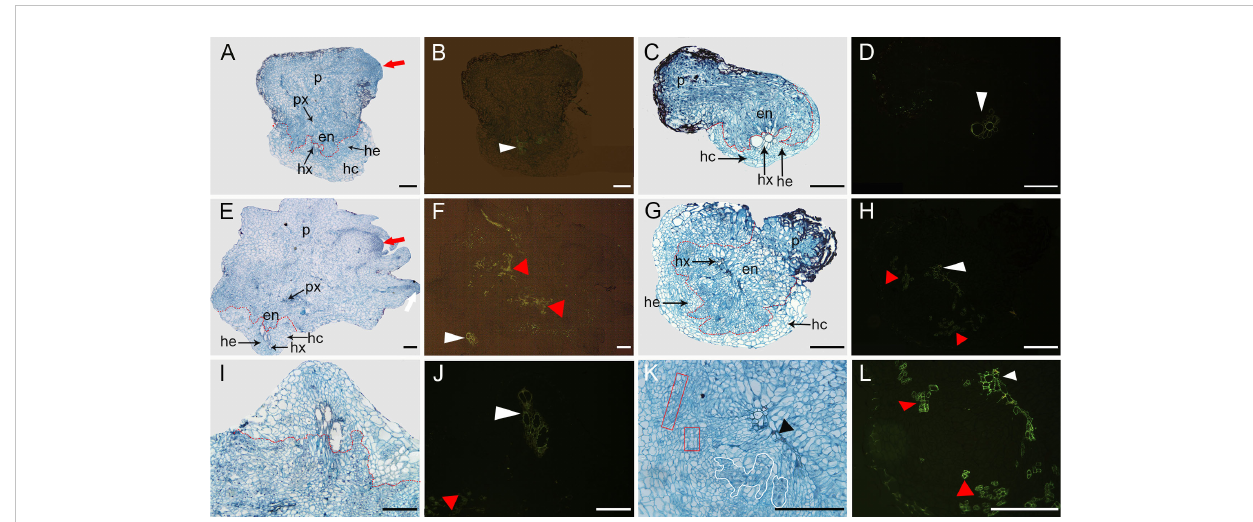
FIGURE 8 Transverse sections through the root and P. aegyptiaca attachment in compatible and incompatible interactions at 16 and 23 DAI. (A, E) Light micrograph of a cross-section in a healthy broomrape on K1076 (16 and 23 DAI). (I) Detail of (E) . (B, F, J) The same as (A, E, I) under fl uorescence microscopy (450 – 490 nm). (C, G) Light micrograph of a cross-section in a slightly discolored and severely browned tubercle on KR1326 (16 and 23 DAI). (K) Detail of (G) . (D, H, L) The same as (C, G, K) under fl uorescence microscopy (450 – 490 nm). p, parasite ( P. aegyptiaca ); px, parasite xylem; hx, host xylem; he, host endodermis; hc, host root cortex; en, endophyte. The red arrow indicates the young stem meristem of the broomrape; the white arrow indicates the secondary root meristem; the white triangle indicates auto fl uorescence of the host xylem; the red triangle indicates auto fl uorescence of the xylem of the broomrape; the black triangle indicates the accumulation of secondary metabolites in the host cell wall; the red box indicates parasite xylem, and a white border indicates parenchyma cells of the parasite. Bars = 200 m